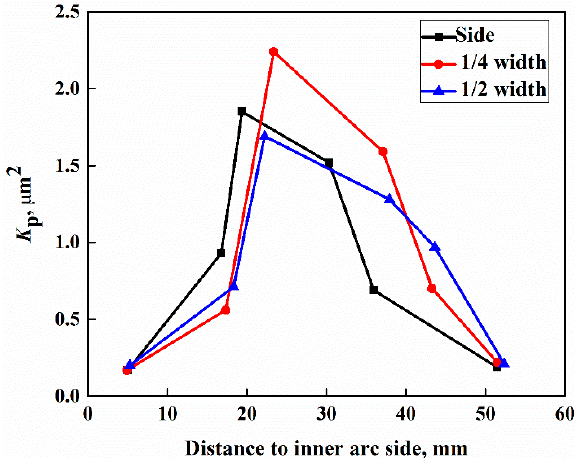
Figure 14. Results of permeability along slab thickness.